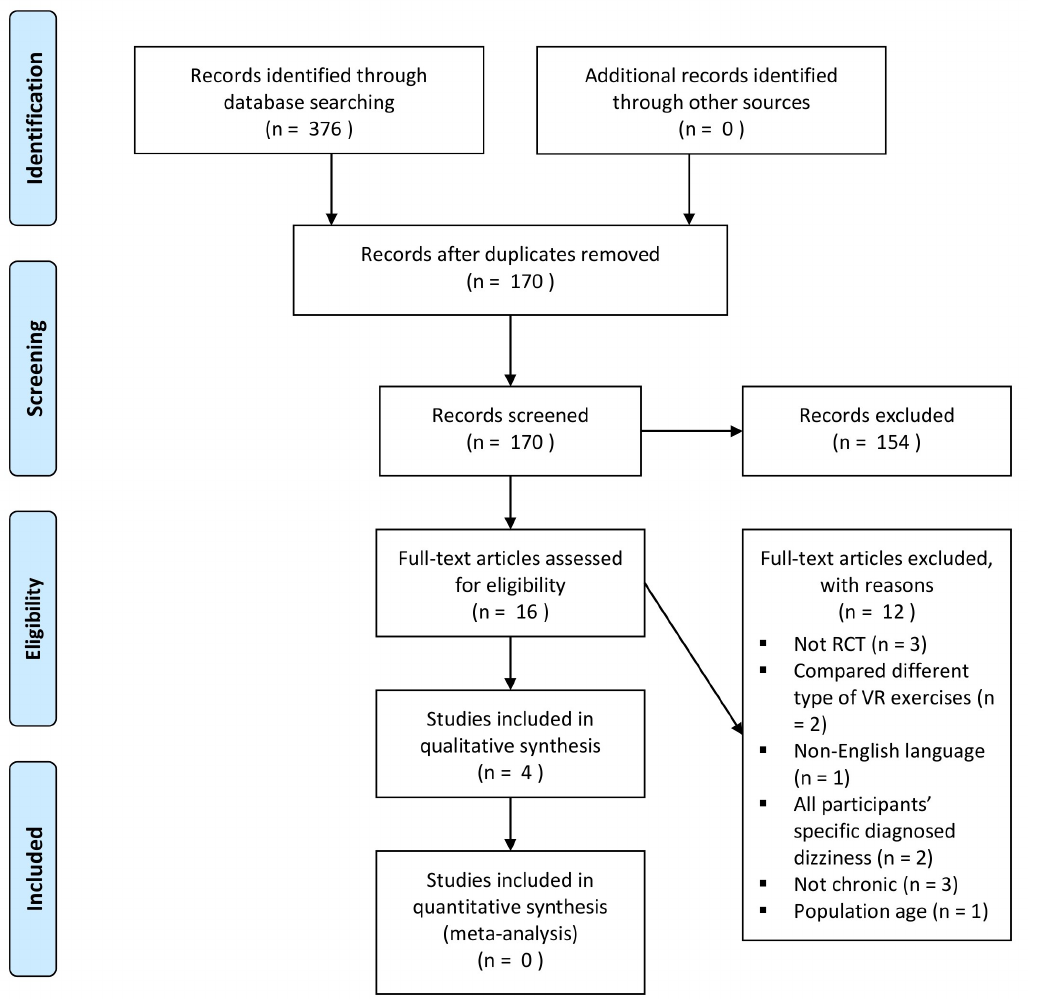
Figure 1. PRISMA diagram of the search strategy and study selection.